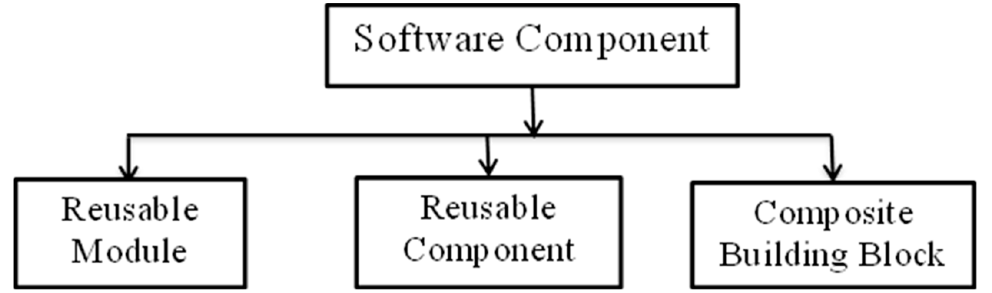
Figure 1. Types of Components.